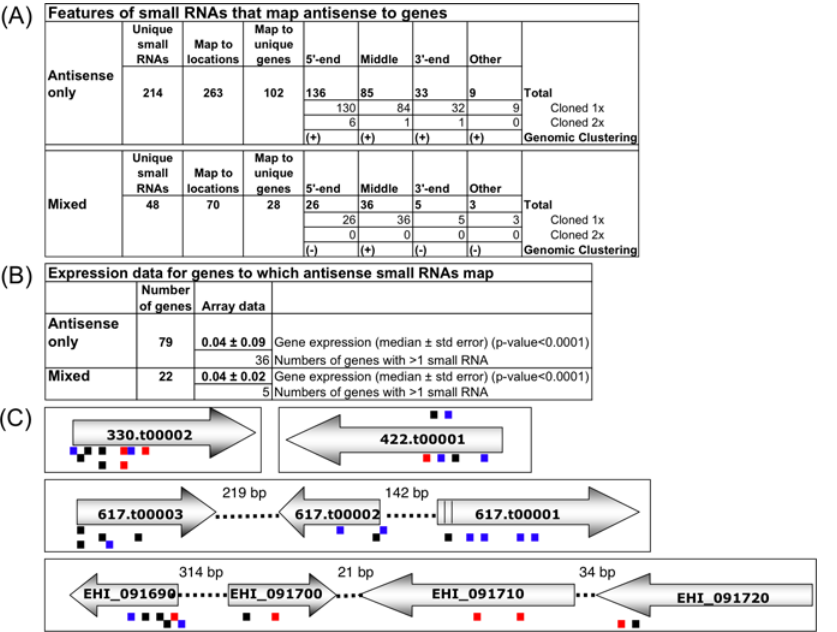
Figure 6. A substantial portion of E.histolytica small RNAs map antisense to predicted open reading frames and are associated with low expression of the cognate gene. (A) Features of small RNAs that map antisense to genes. 214 unique small RNAs map antisense to genes at 263 genomic locations, and to 102 unique genes. 48 unique small RNAs map to multiple genomic locations, including mapping antisense to genes at 70 genomic locations, and to 28 unique genes. The locations to which small RNAs map (5 9 region, middle, or 3 9 region) and small RNA abundance (cloned 2x) are listed. Small RNAs that map to UTRs or intron are listed under ‘‘other.’’ Evidence of genomic clustering is listed. (B) Features of genes to which small RNAs map antisense. The median expression level 6 standard error of the 79 genes to which antisense small RNAs map and the 22 genes to which antisense small RNAs that map to mixed locations are shown. The numbers of genes with . 1 small RNA mapping to them are shown. (C) Schematic of small RNAs and their patterns of mapping to amebic genes. Small RNAs that map antisense to genes are shown below genes; small RNAs that map sense to genes are shown above the gene. A substantial portion of small RNAs map to the 5 9 ends of genes. Multiple, non- overlapping small RNAs are identified for some genes and genomic clustering (adjacent genes with antisense small RNAs) is observed. Small RNAs cloned in a 5 9 -P dependent manner are shown as small black lines; small RNAs cloned in a 5 9 -P independent manner are shown as small red lines; small RNAs cloned from the Myc-EhPiwi-rp immunoprecipitated sample are shown as small blue lines. Genes are shown as large grey arrows and are represented by .t or EHI numbers. UTR is represented by |||. Small RNAs are drawn to scale relative to their mapped loci.